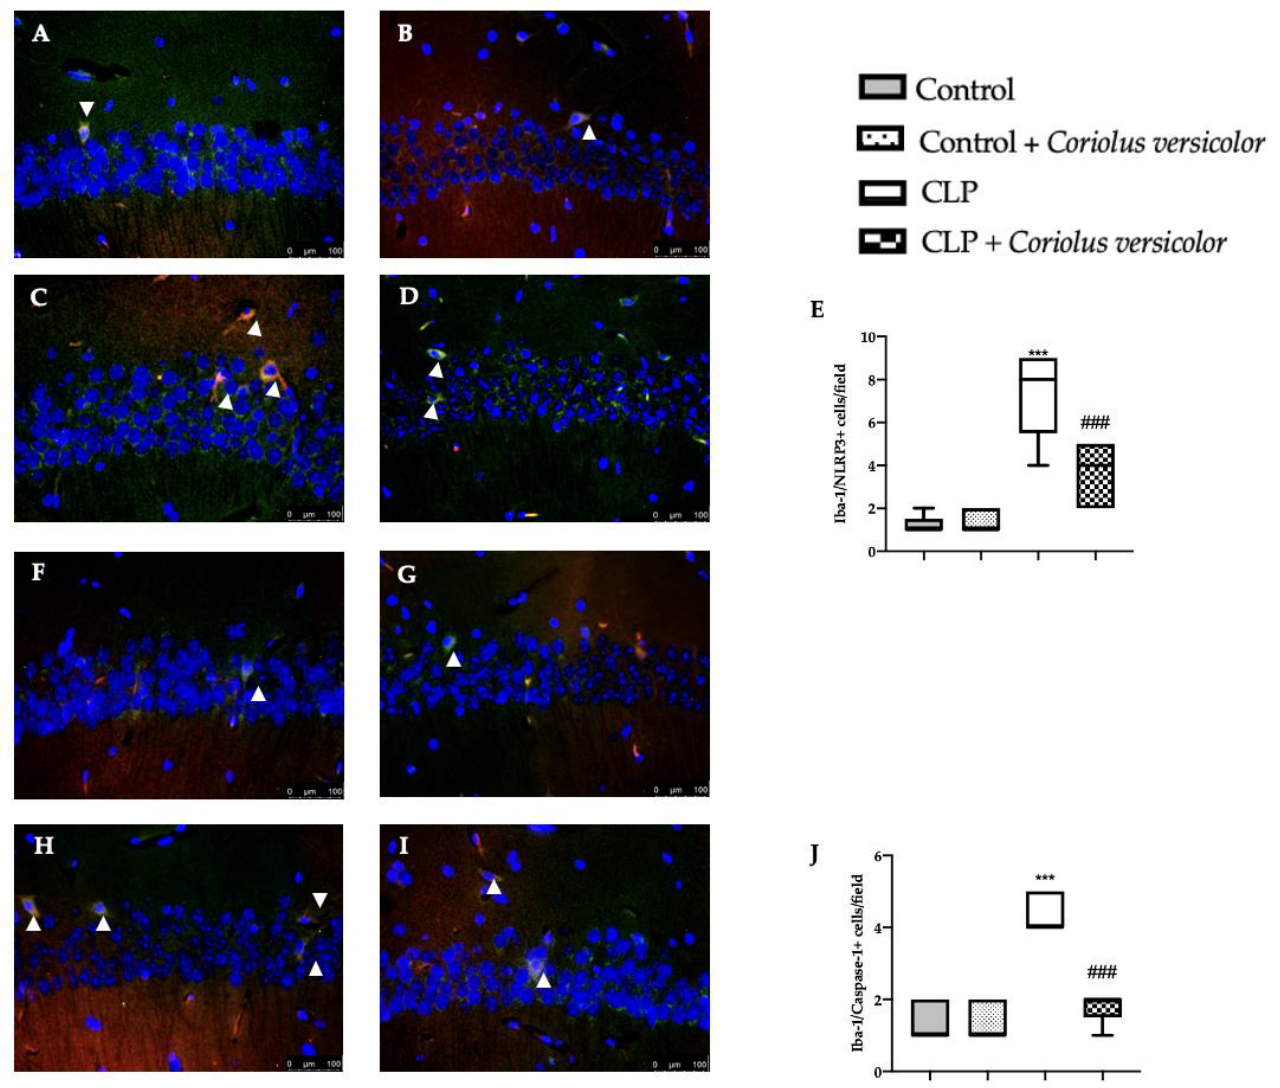
Figure 11. Coriolus versicolor reduced Ionized calcium-binding adapter molecule1 (Iba-1)/ NLR family pyrin domain containing 3 (NLRP3) and Iba-1/Caspase-1 colocalization induced by CLP 28 days after surgery. Immunofluorescence analysis of Iba-1/NLRP3: Control ( A ), Control + Coriolus versicolor ( B ), CLP ( C ), CLP + Coriolus versicolor ( D ), graphical quantification of Iba-1/NLRP3 colocalization ( E ), immunofluorescence analysis of Iba-1/Caspase-1: Control ( F ), Control + Coriolus versicolor ( G ), CLP ( H ), CLP + Coriolus versicolor ( I ), graphical quantification of Iba-1/Caspase-1 colocalization ( J ). *** p < 0.001 vs. control, ### p < 0.001 vs. CLP.